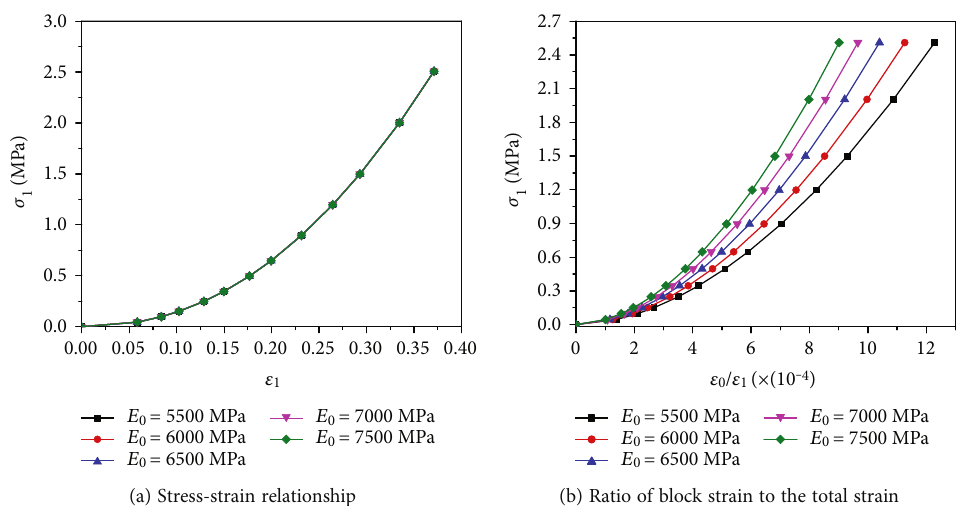
Figure 8: Sensitivity of the stress-strain curves to the elastic modulus of broken rock.